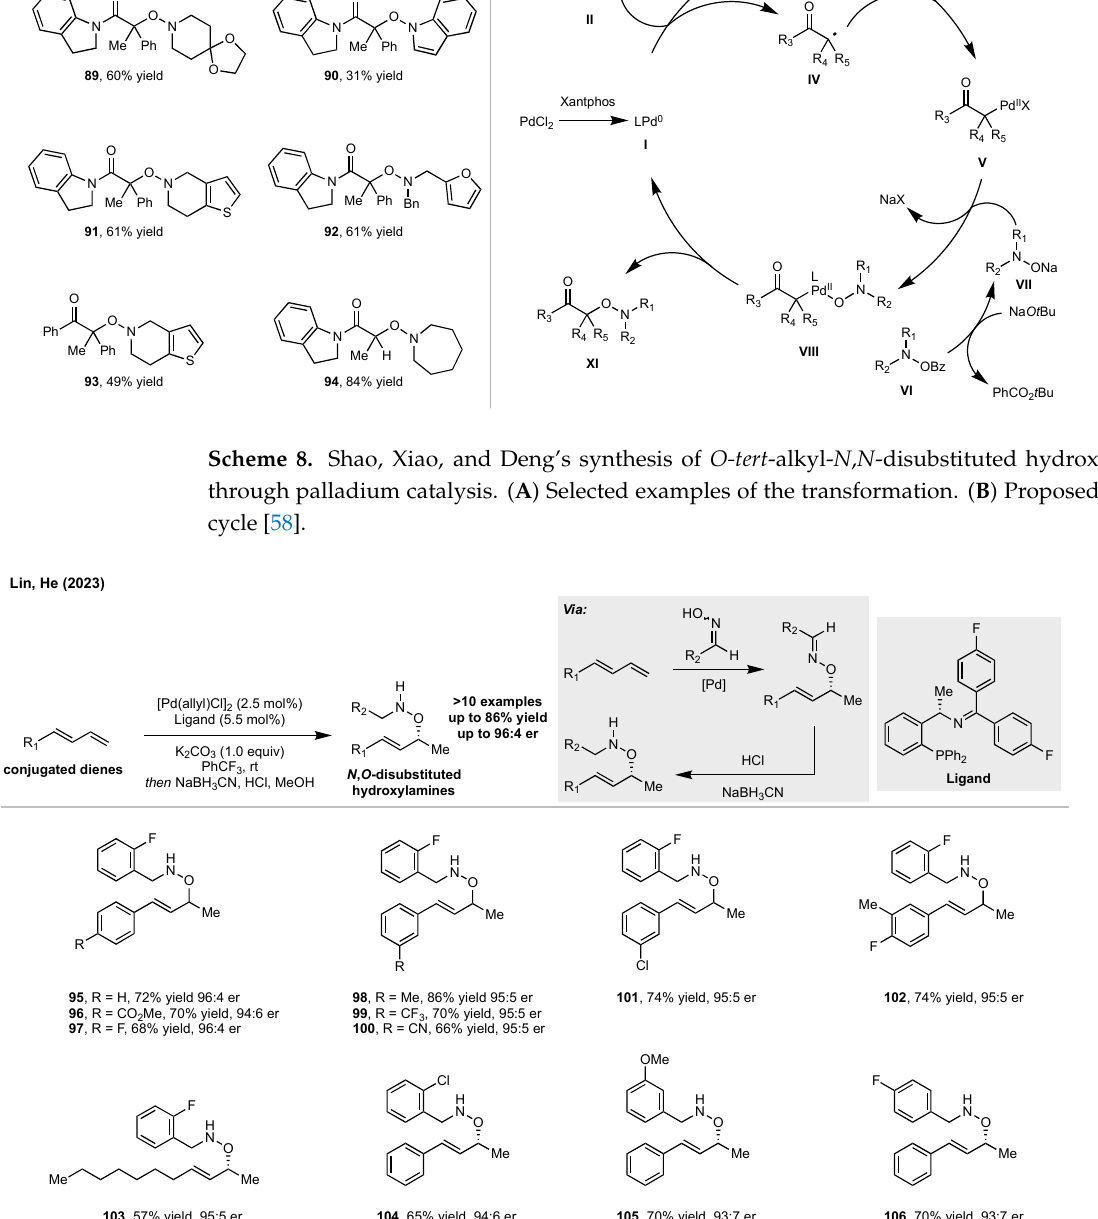
Scheme 9. Lin and He(cid:31)s catalytic asymmetric synthesis of secondary allylic hydroxylamines from conjugated dienes [61].